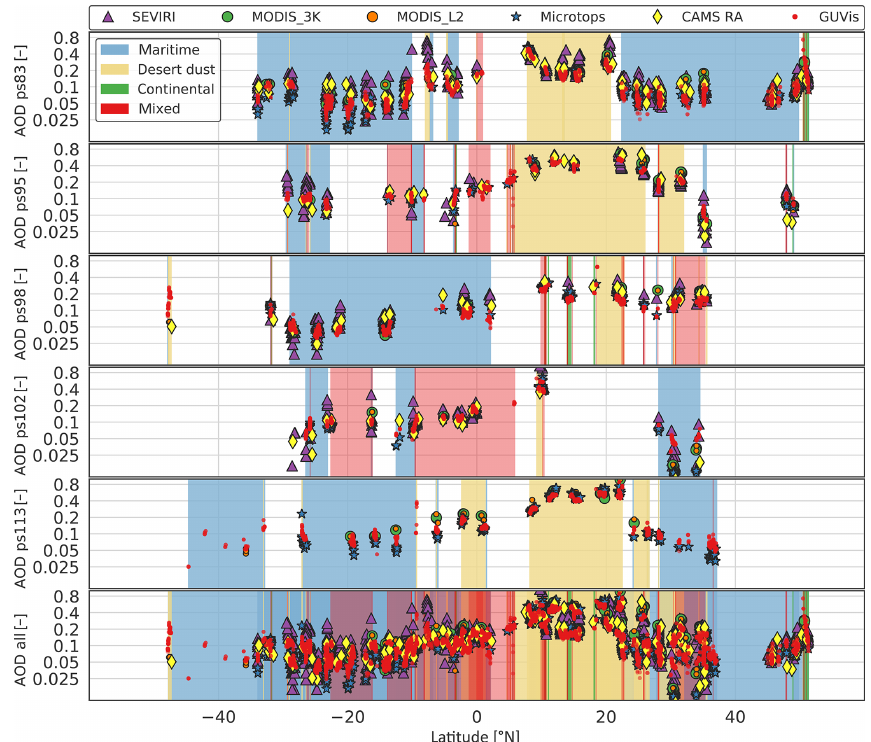
Figure 1. Zonal cross section of AOD at 630nm estimated from GUVis measurements during the Polarstern PS83, PS95, PS98, PS102, and PS113 cruises, together with collocated AOD obtained from Microtops, satellite products, and CAMS RA. Along this cross section across the Atlantic Ocean, the dominant aerosol type is either maritime (blue shaded region) or desert dust (yellow shaded region) while passing the Sahara desert. The aerosol classification method is based on the method of Toledano et al. (2007) and GUVis